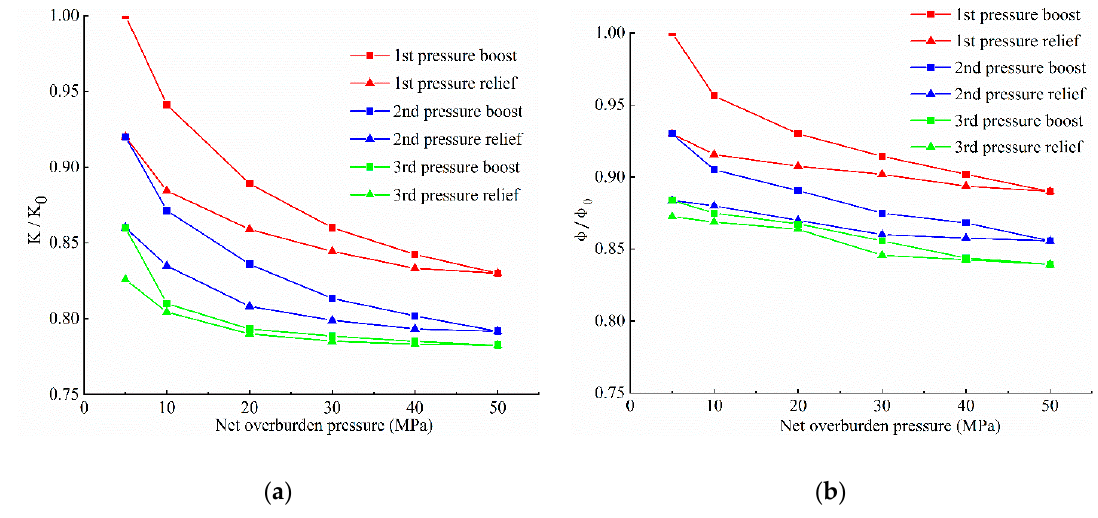
Figure 4. The permeability ( a ) and porosity ( b ) change curve of A1 core with net overburden pressure.